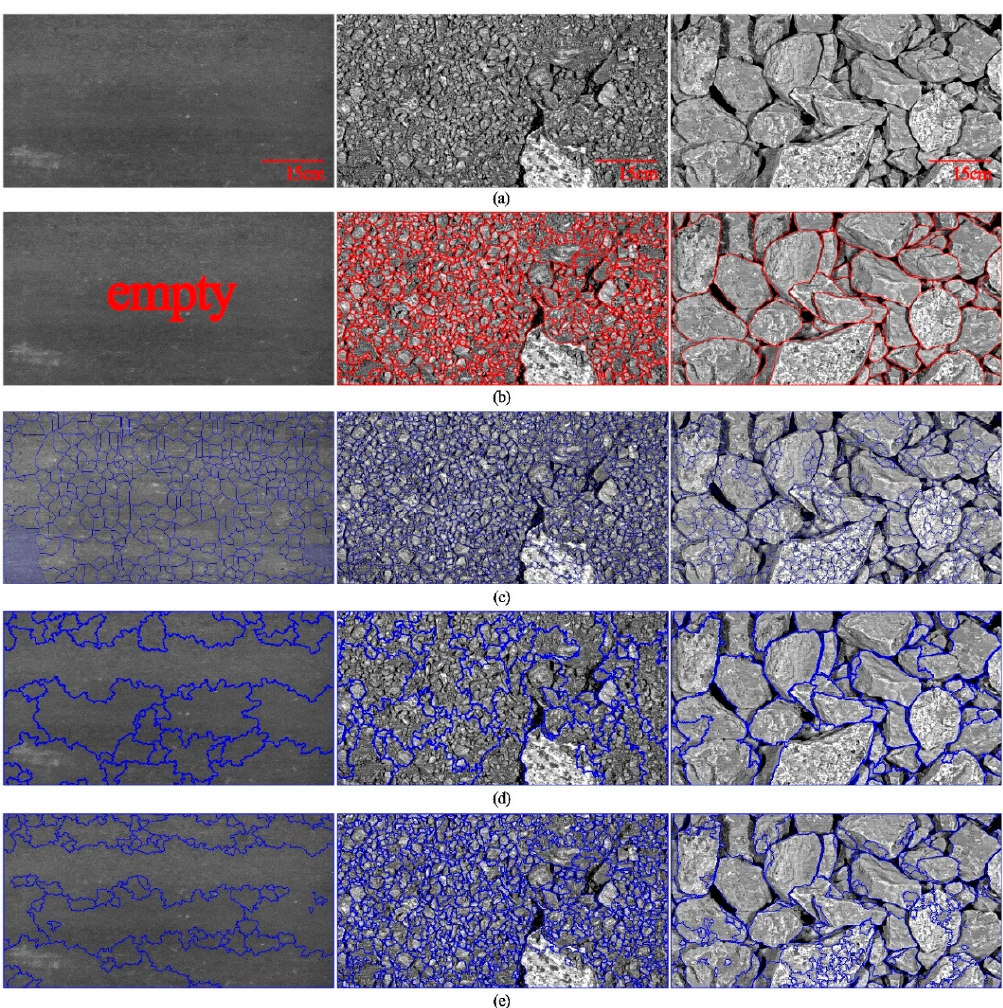
Figure 9. The segmentation results processed by different algorithms: the original images ( a ), manual segmentation ( b ), process control system (PCS) ( c ), CIS ( d ), and FIS ( e ).